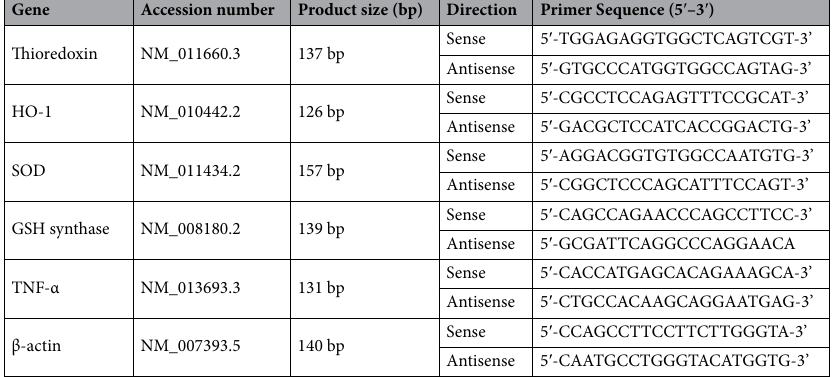
Table 1. Primers used for quantitative real time PCR in